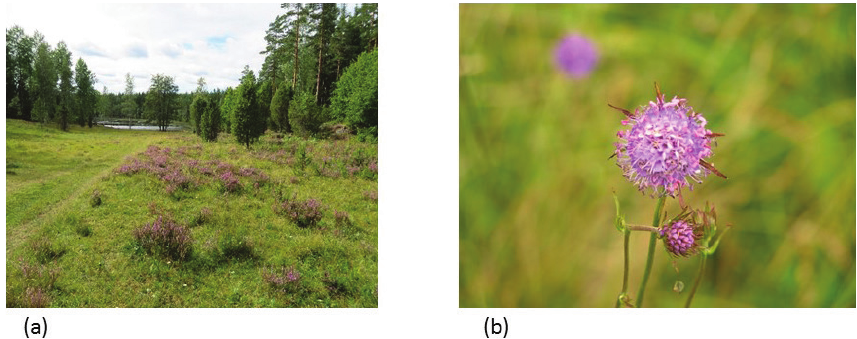
Figure 3. Biological cultural heritage may refer to a site where historical management has created species- rich grasslands, as well as to single species. a A semi-natural grassland at the Natura 2000 site of Stora Åsa, Province of Södermanland, Sweden. b Succisa pratensis , a species characteristic for these grasslands and which remains as legacy in forests long after management has ceased (Herben et al. 2006). Photo: Ove Eriksson.